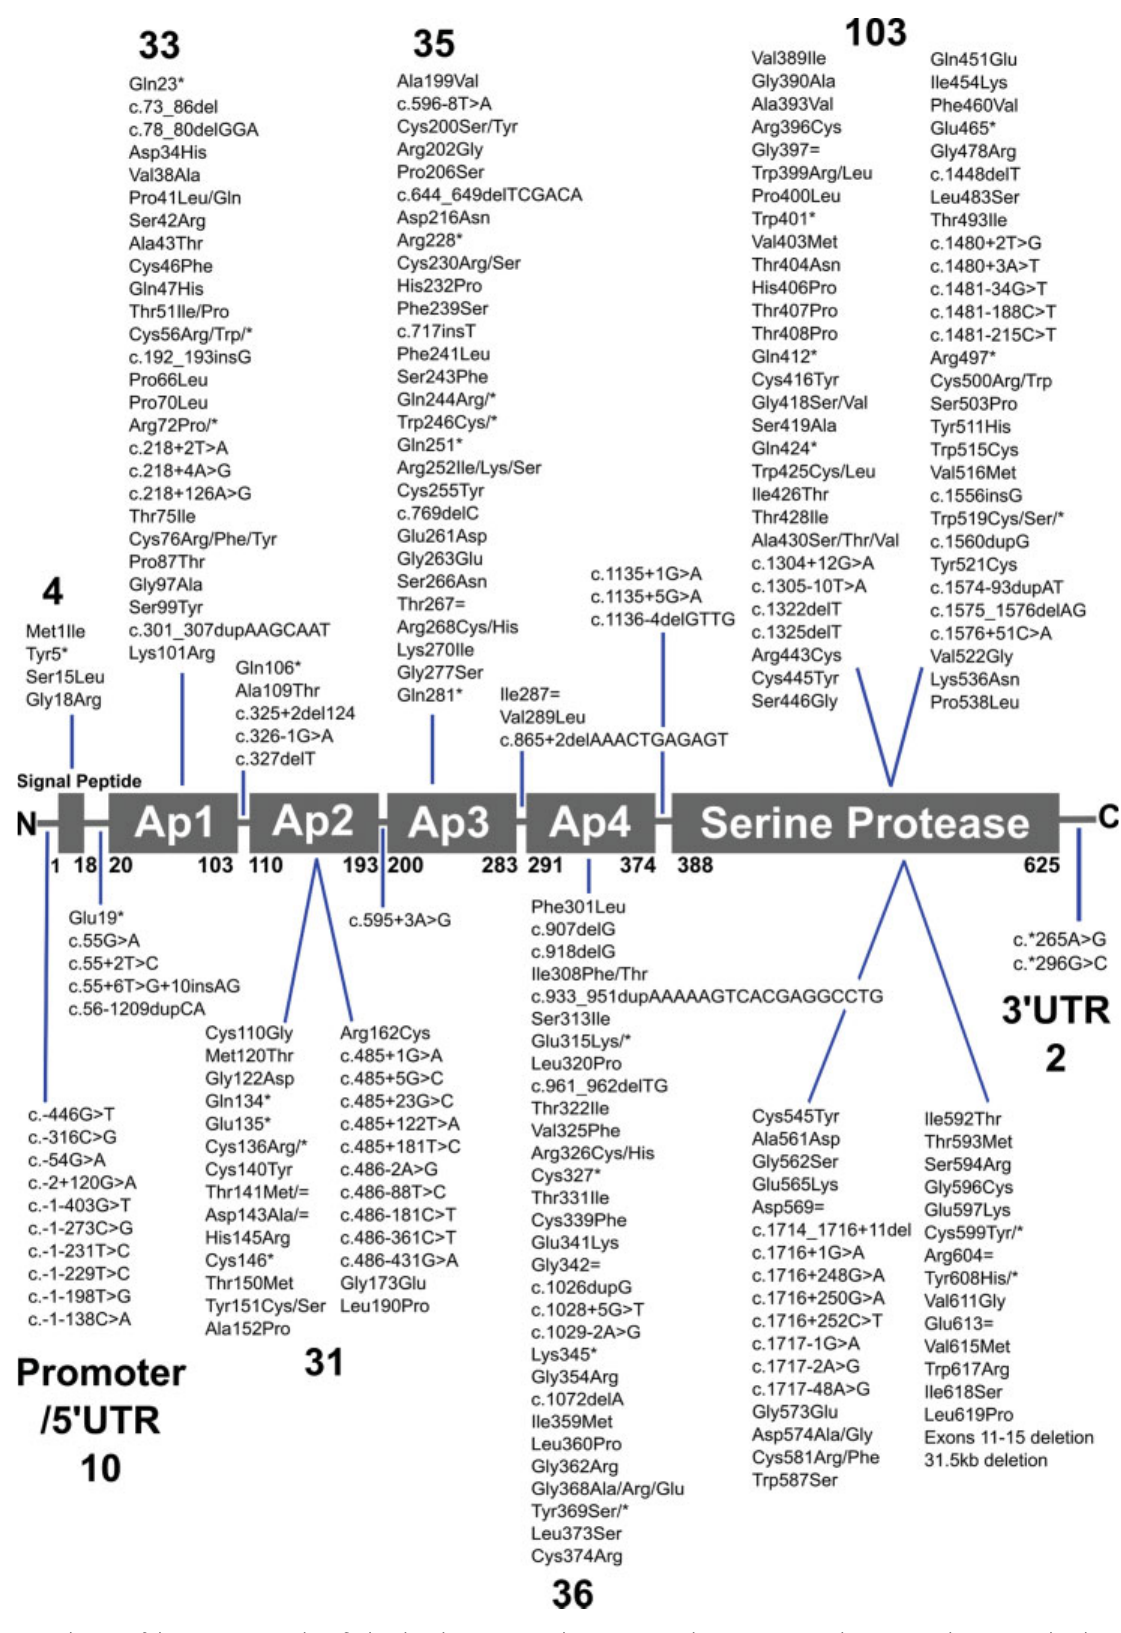
Fig. 1 Distribution of the 272 variants identi fi ed within the F11 gene. The Ap1-Ap4 and serine protease domains are drawn to scale. The number of variants in each of the respective domains and UTR regions is shown in large font above or below the variant lists. Intronic variants are included in their respective domains according to sequence numbering. The residue numbering in HGVS format (starting with 1 at the signal peptide) denotes the amino acids that start and end each domain. N and C represent the N- and C-termini of FXI respectively. Note that the two variants in the 3 ′ UTR do not follow HGVS